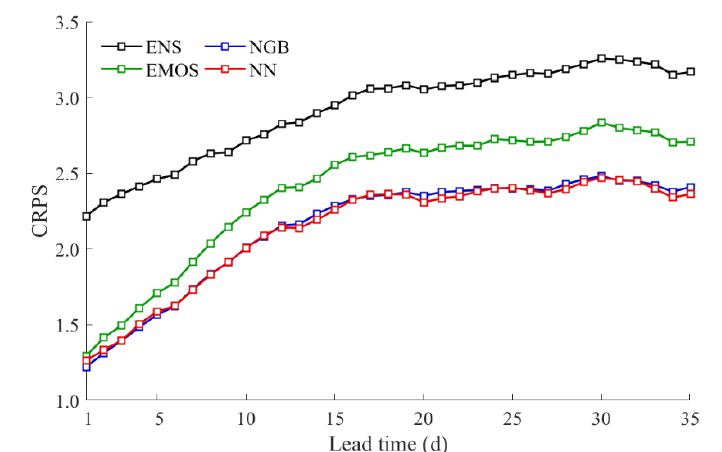
Figure 3. Mean continuous ranked probability skill score of the different post-processing methods for the 2-m maximum air temperature at all land grid points over East Asia in 2016 with lead times of 1–35 days. CRPS, continuous ranked probability score; ENS, raw ensemble; EMOS, ensemble model output statistics; NGB, natural gradient boosting; NN, neural networks.